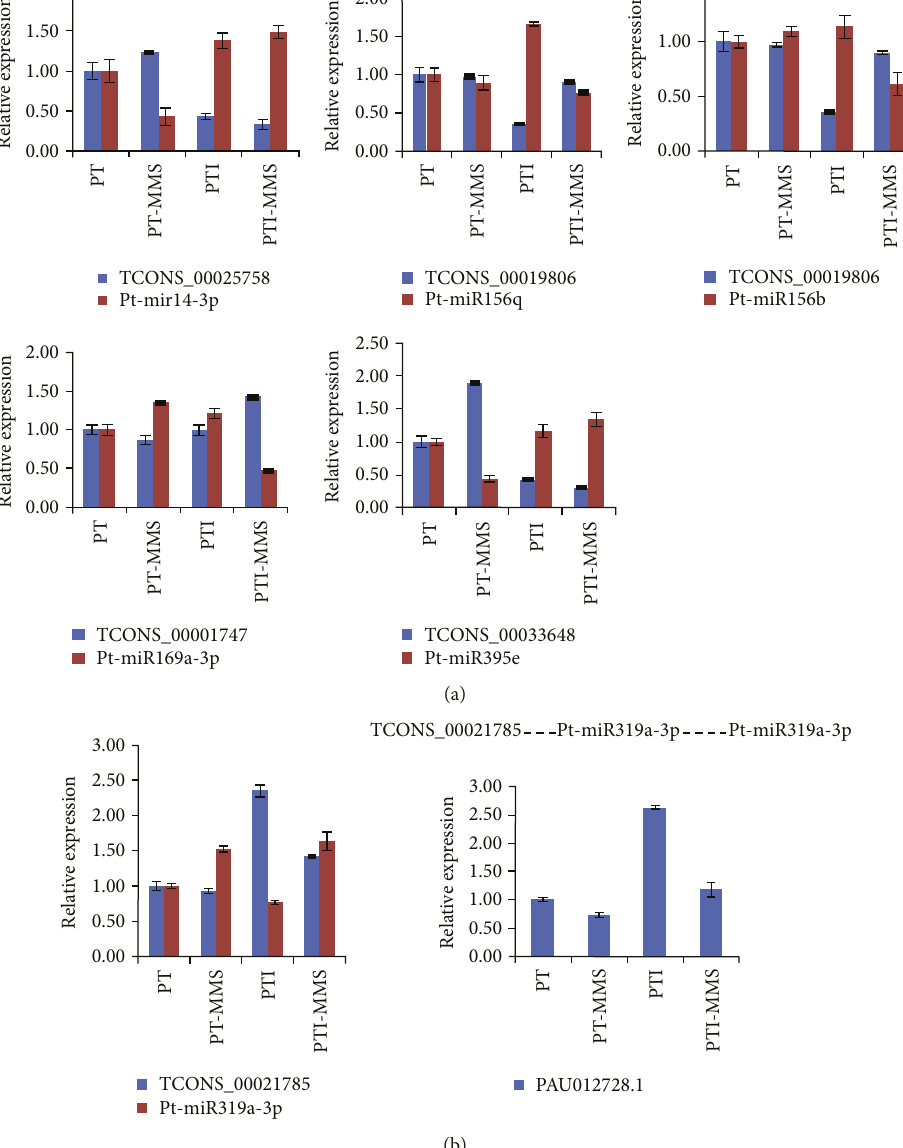
Figure 2: Expression analysis of lncRNAs as potential targets or target mimics of miRNAs. (a) Quantitative RT-PCR analysis of miRNAs and their potential target lncRNAs. (b) Quantitative RT-PCR analysis of TCONS_00021785 and one potential target gene of pt-miR319a-3p